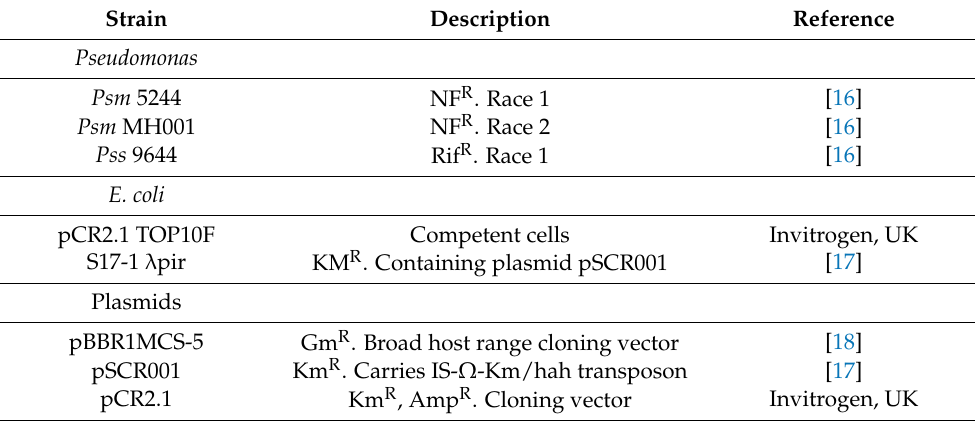
Table 1. Bacterial strains and